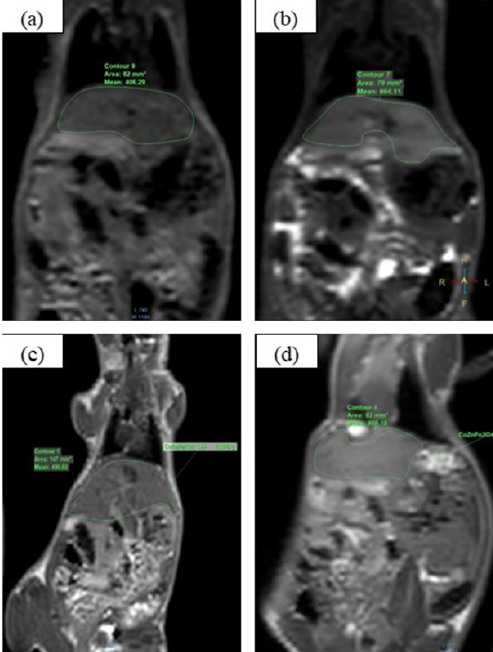
Figure 7. Three-dimensional MRI images of mice liver from ( a ) normal mice; ( b ) mice injected with gadolinium; ( c ) mice injected with chitosan-coated Co 0.5 Zn 0.5 Fe 2 O 4 nanoparticles without external magnetic field assistance; and ( d ) mice injected with chitosan-coated Co 0.5 Zn 0.5 Fe 2 O 4 nanoparticles with 400 mT of external magnetic field assistance. In Supplementary Materials you can find the whole MRI measurement (Video S1) of mice liver from ( a ) normal mice (left), ( b ) mice injected with chitosan-coated Co 0.5 Zn 0.5 Fe 2 O 4 nanoparticles with 400 mT of external magnetic field assistance (middle), ( c ) mice injected with chitosan-coated Co 0.5 Zn 0.5 Fe 2 O 4 nanoparticles without external mag- netic field assistance (right); and Video S2 of mice liver from ( b ) both mice injected with gadolinium.